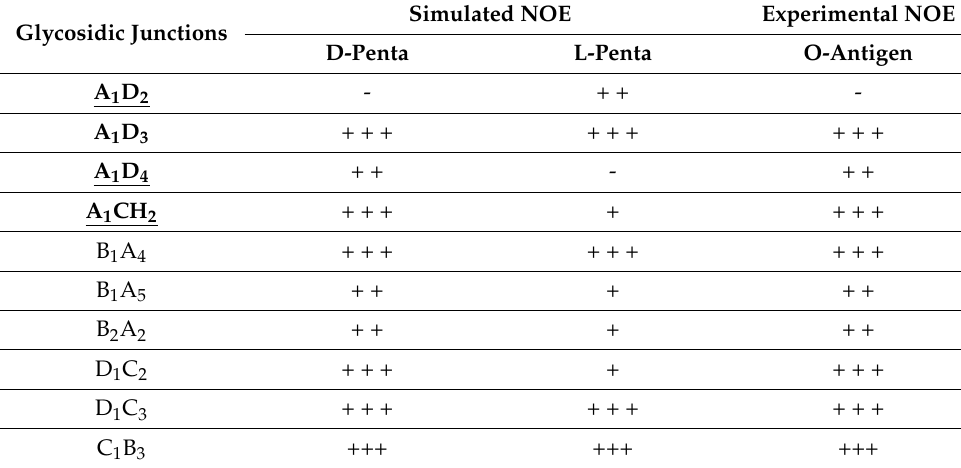
Table 2. Comparison of simulated NOE values of both D -penta (B-A-dD-C-B’) and L -penta (B-A-lD- C-B’) with the experimental ones, which were obtained from the NOESY spectrum recorded for the O-antigen isolated from Cupriavidus metallidurans CH34. The intensities of the NOE are classified as strong (+++), medium (++), and weak (+) based on the following interprotonic distances (in Å): (+++) 2.5–2.0; (++) 3.0–2.5; (+) 4.0–3.0. The discriminating NOEs for the evaluation of the absolute configuration of bacillosamine are in bold and underlined. Capital letters correspond to the labels used during the NMR characterization (Figure 1 and Table